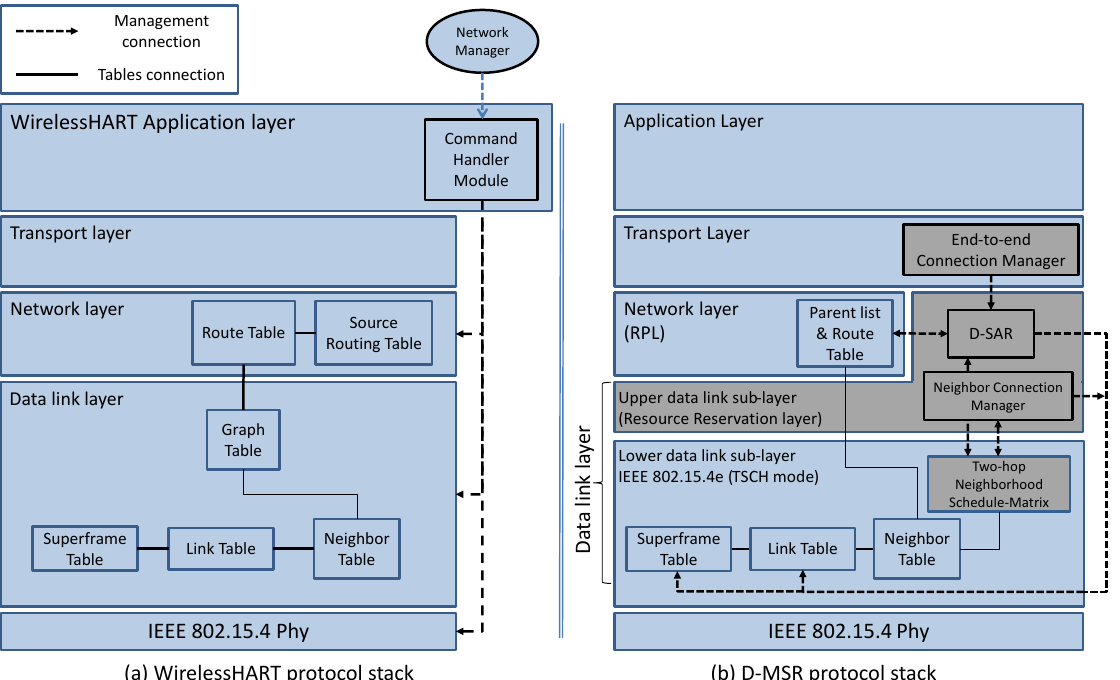
Figure 5. WirelessHART ( a ) and D-MSR ( b ) protocol stack.